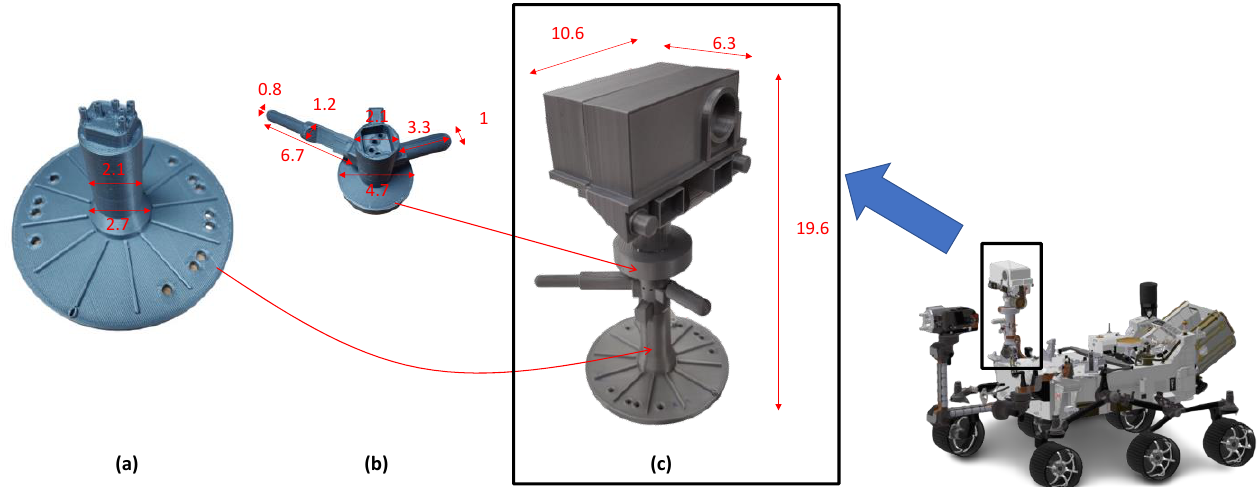
Figure 7. ( a ) Printed section between the bottom and the beginning of the prism attached to the mast; ( b ) printed section between the beginning of the prism and the end of the ring, including dimensions in cm; ( c ) result of the design and manufacture of the mast of the Mars rover Perseverance , including dimensions in cm.